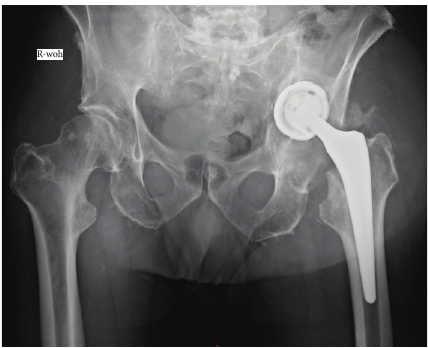
Figure 1: Radiograph of pelvis (deep) after fall: periprosthetic ace- tabular fracture (type IIIa acetabular defect according to Paprosky et al. [20]).